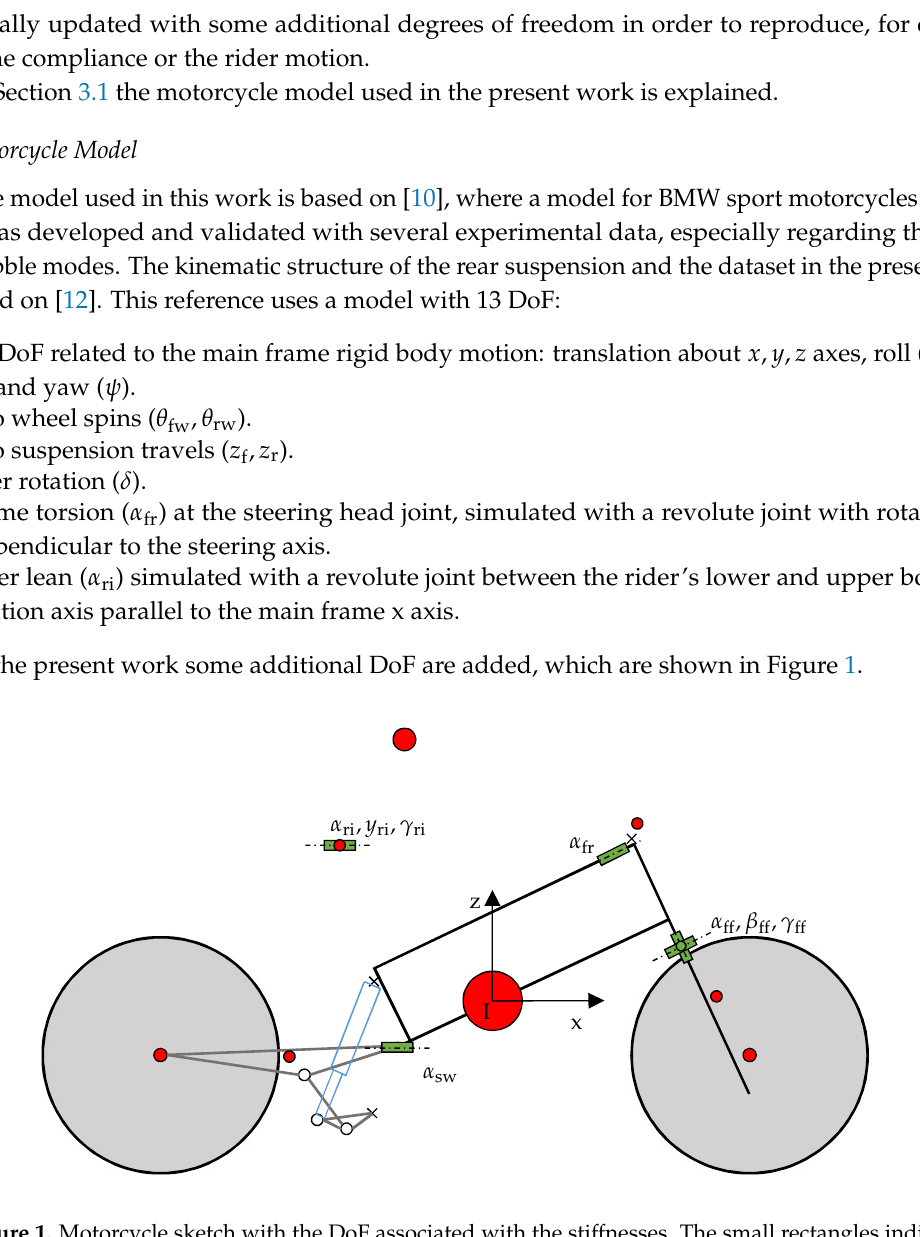
Figure 1. Motorcycle sketch with the DoF associated with the stiffnesses. The small rectangles indicate the related joints. The red points represent the bodies’ centre of